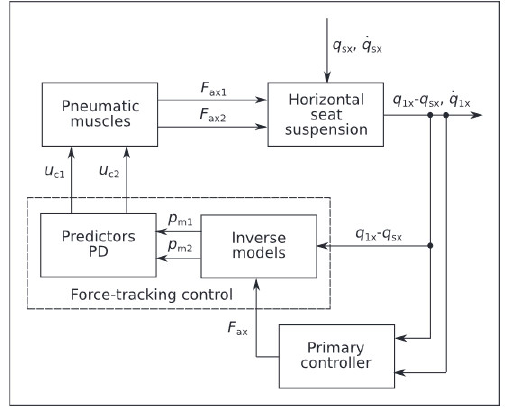
Figure 9. Block diagram of the control structure of the vibration control system [55].